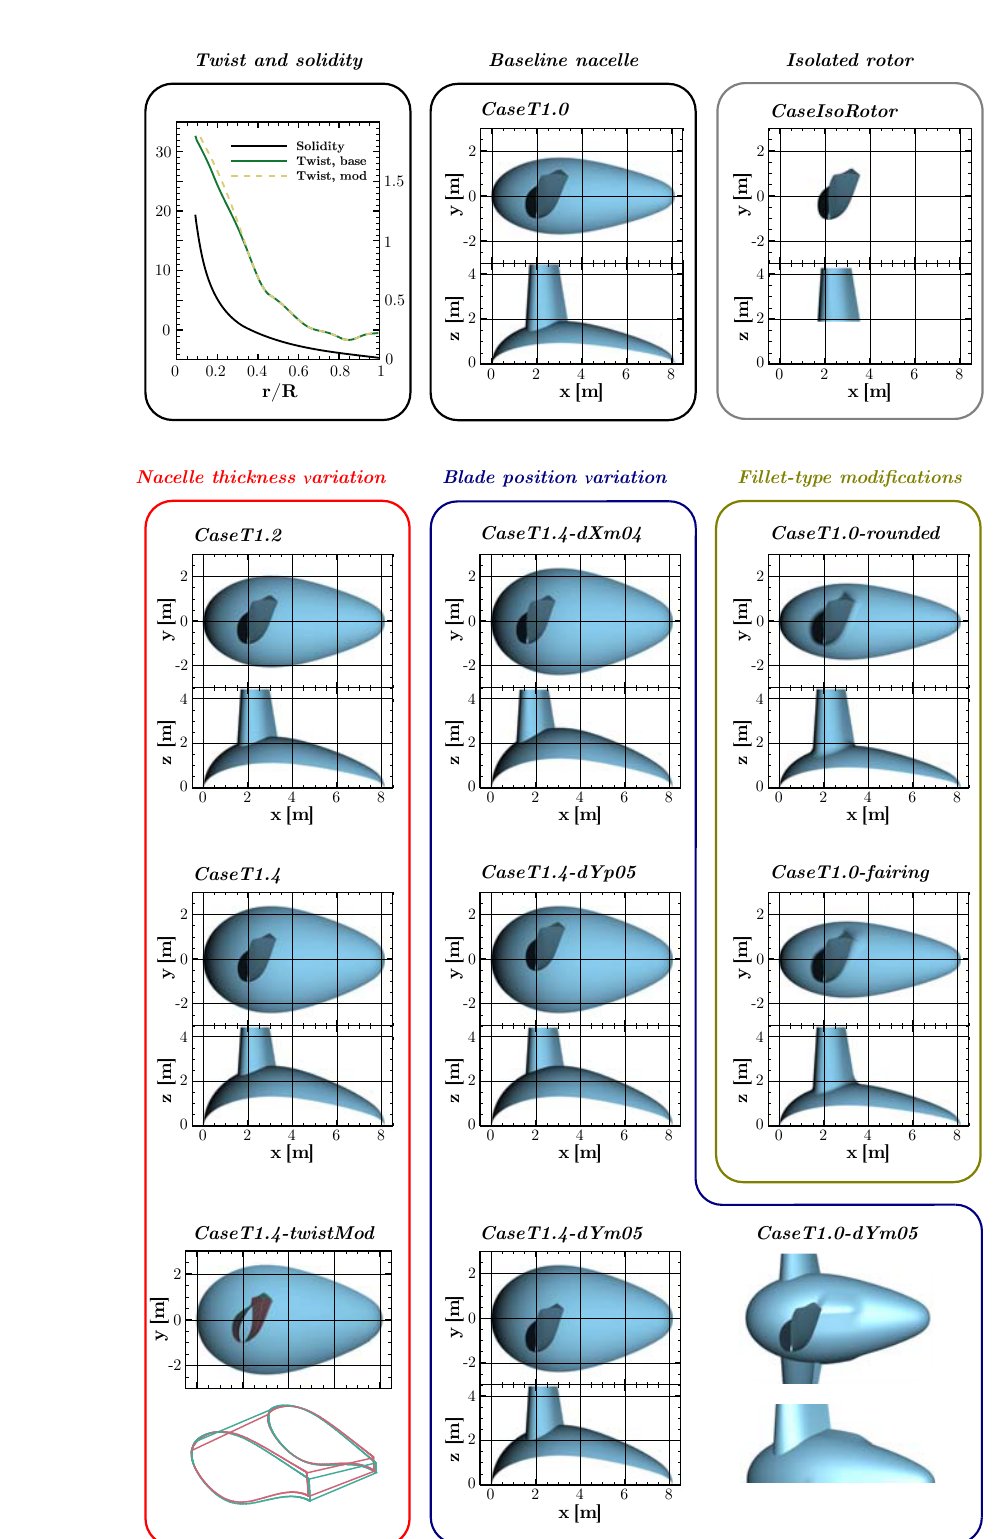
Figure 1. Considered geometric variations of the blade–nacelle